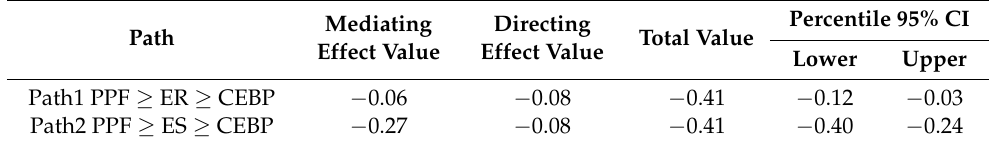
Table 4. Mediation analysis of externalizing behavior problems.